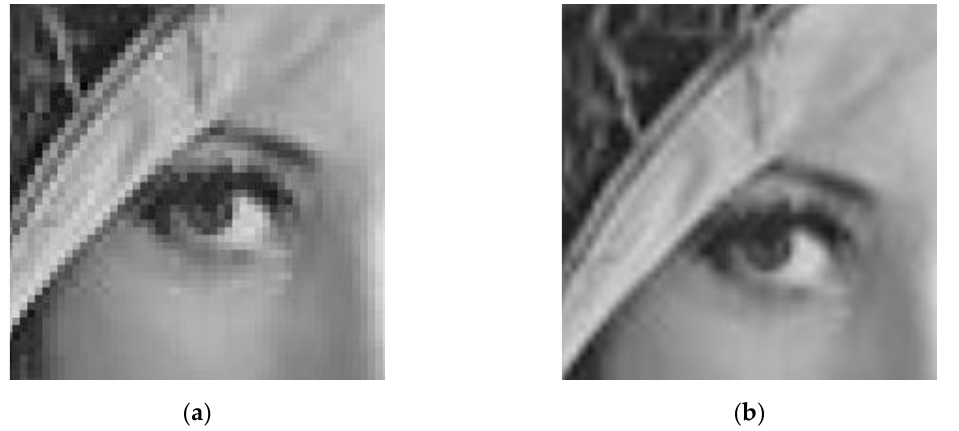
Figure 4. Comparison of eye effects of the nearest neighbor interpolation and the proposed rational interpolation. ( a ) The zoomed images by factor 4 based on the nearest-neighbor interpolation method, ( b ) the zoomed images by factor 4 based on the proposed